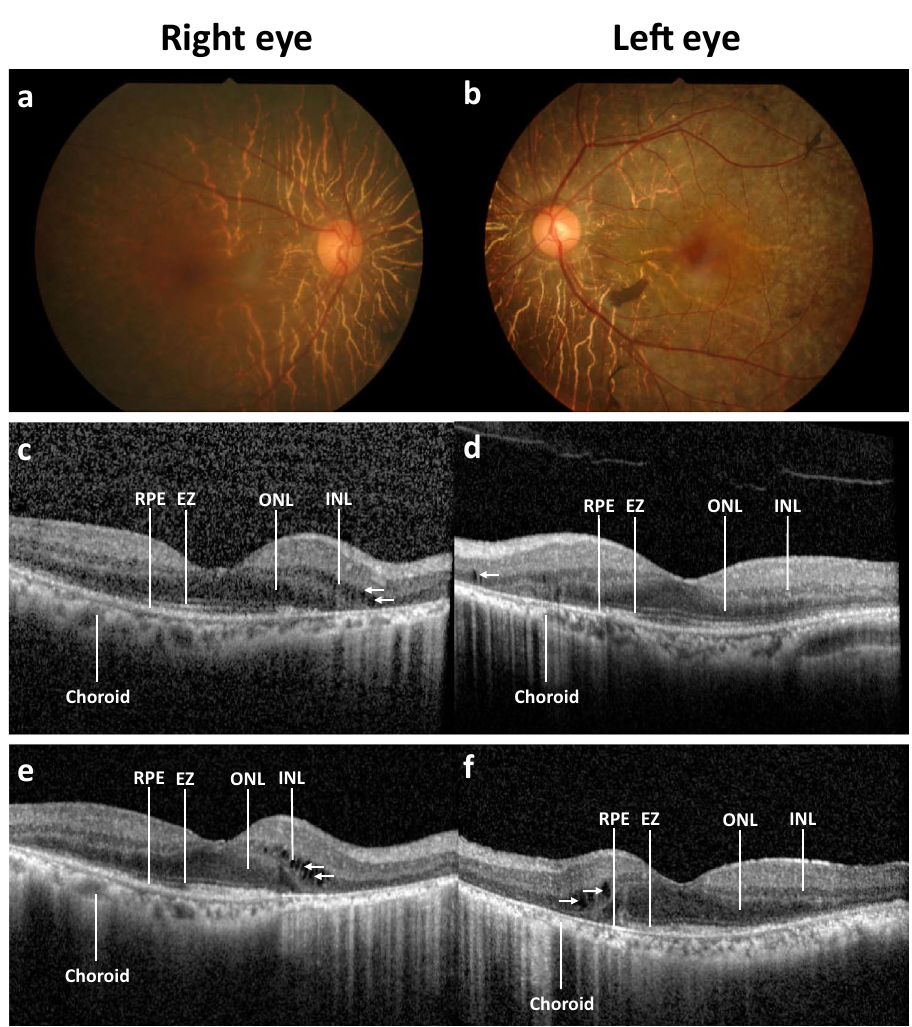
Figure 1. Disease progression of a patient with autoimmune retinopathy (AIR). Color fundus photography at baseline in the right ( a ) and left eye ( b ) shows normal optic disc, arteriolar attenuation, generalized retinal pigment epithelium (RPE) atrophy with macular sparing and scattered pigment clumps. Prominent large choroidal vessels can be observed around the optic disc. Optical coherence tomography images at baseline showing RPE attenuation, loss of ellipsoid zone (EZ) at the periphery, flattening of the outer nuclear layer (ONL), and slit cavitation in the inner nuclear layer (INL) on the nasal side, as marked by arrows, in the right ( c ) and left eye ( d ). The disease progression after five years is marked with RPE atrophy, progressive loss of EZ and ONL toward the fovea, more prominent slit cavitation in the INL, as marked by arrows, and accompanying choroidal thinning in the right ( e ) and left eye ( f ). The data is retrieved from patient number